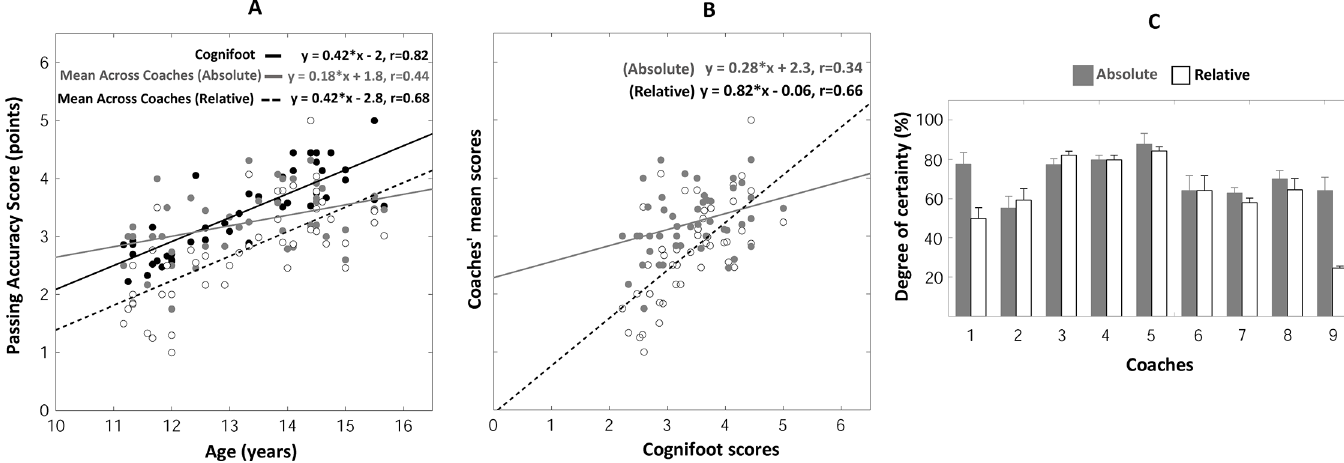
Fig 5. Passing accuracyscores as a function of age, measuredby the Cognifootsystem or judgedby coaches(A)—Cognifoot scores vs mean coaches’ scores (B) Degreesof certainty of the coaches in their -passingaccuracy- judgments (C).